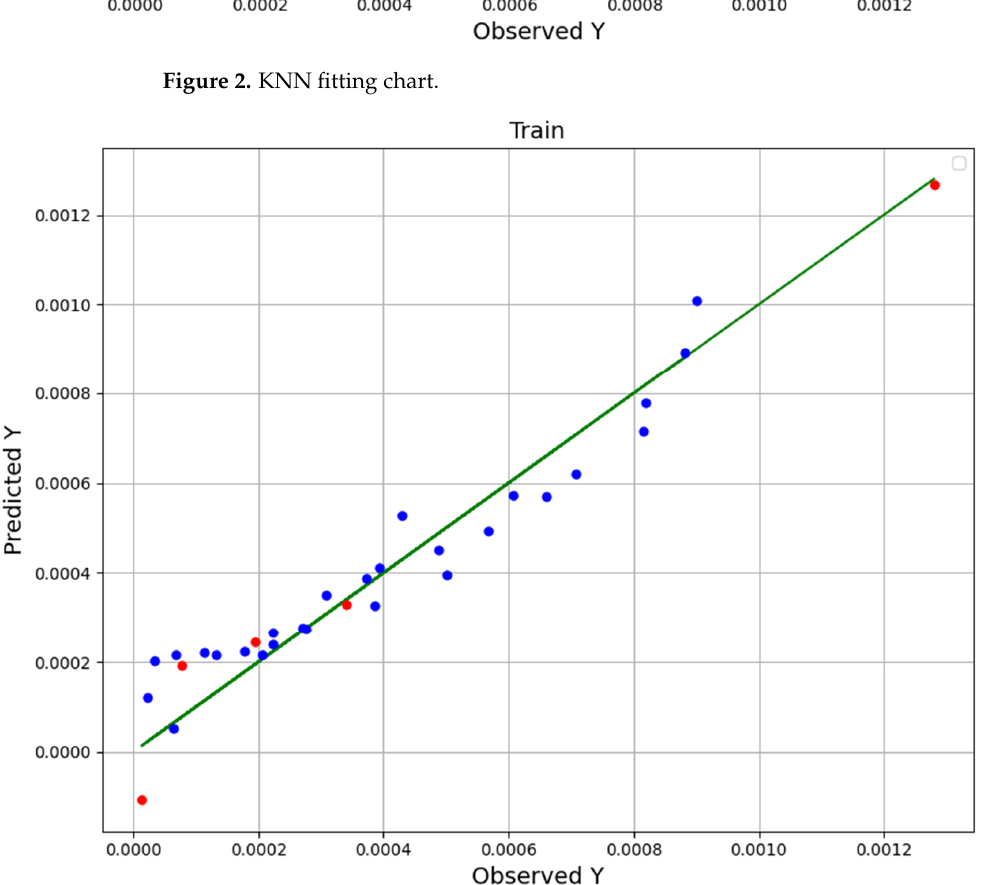
Figure 3. NU-SVR fitting chart.